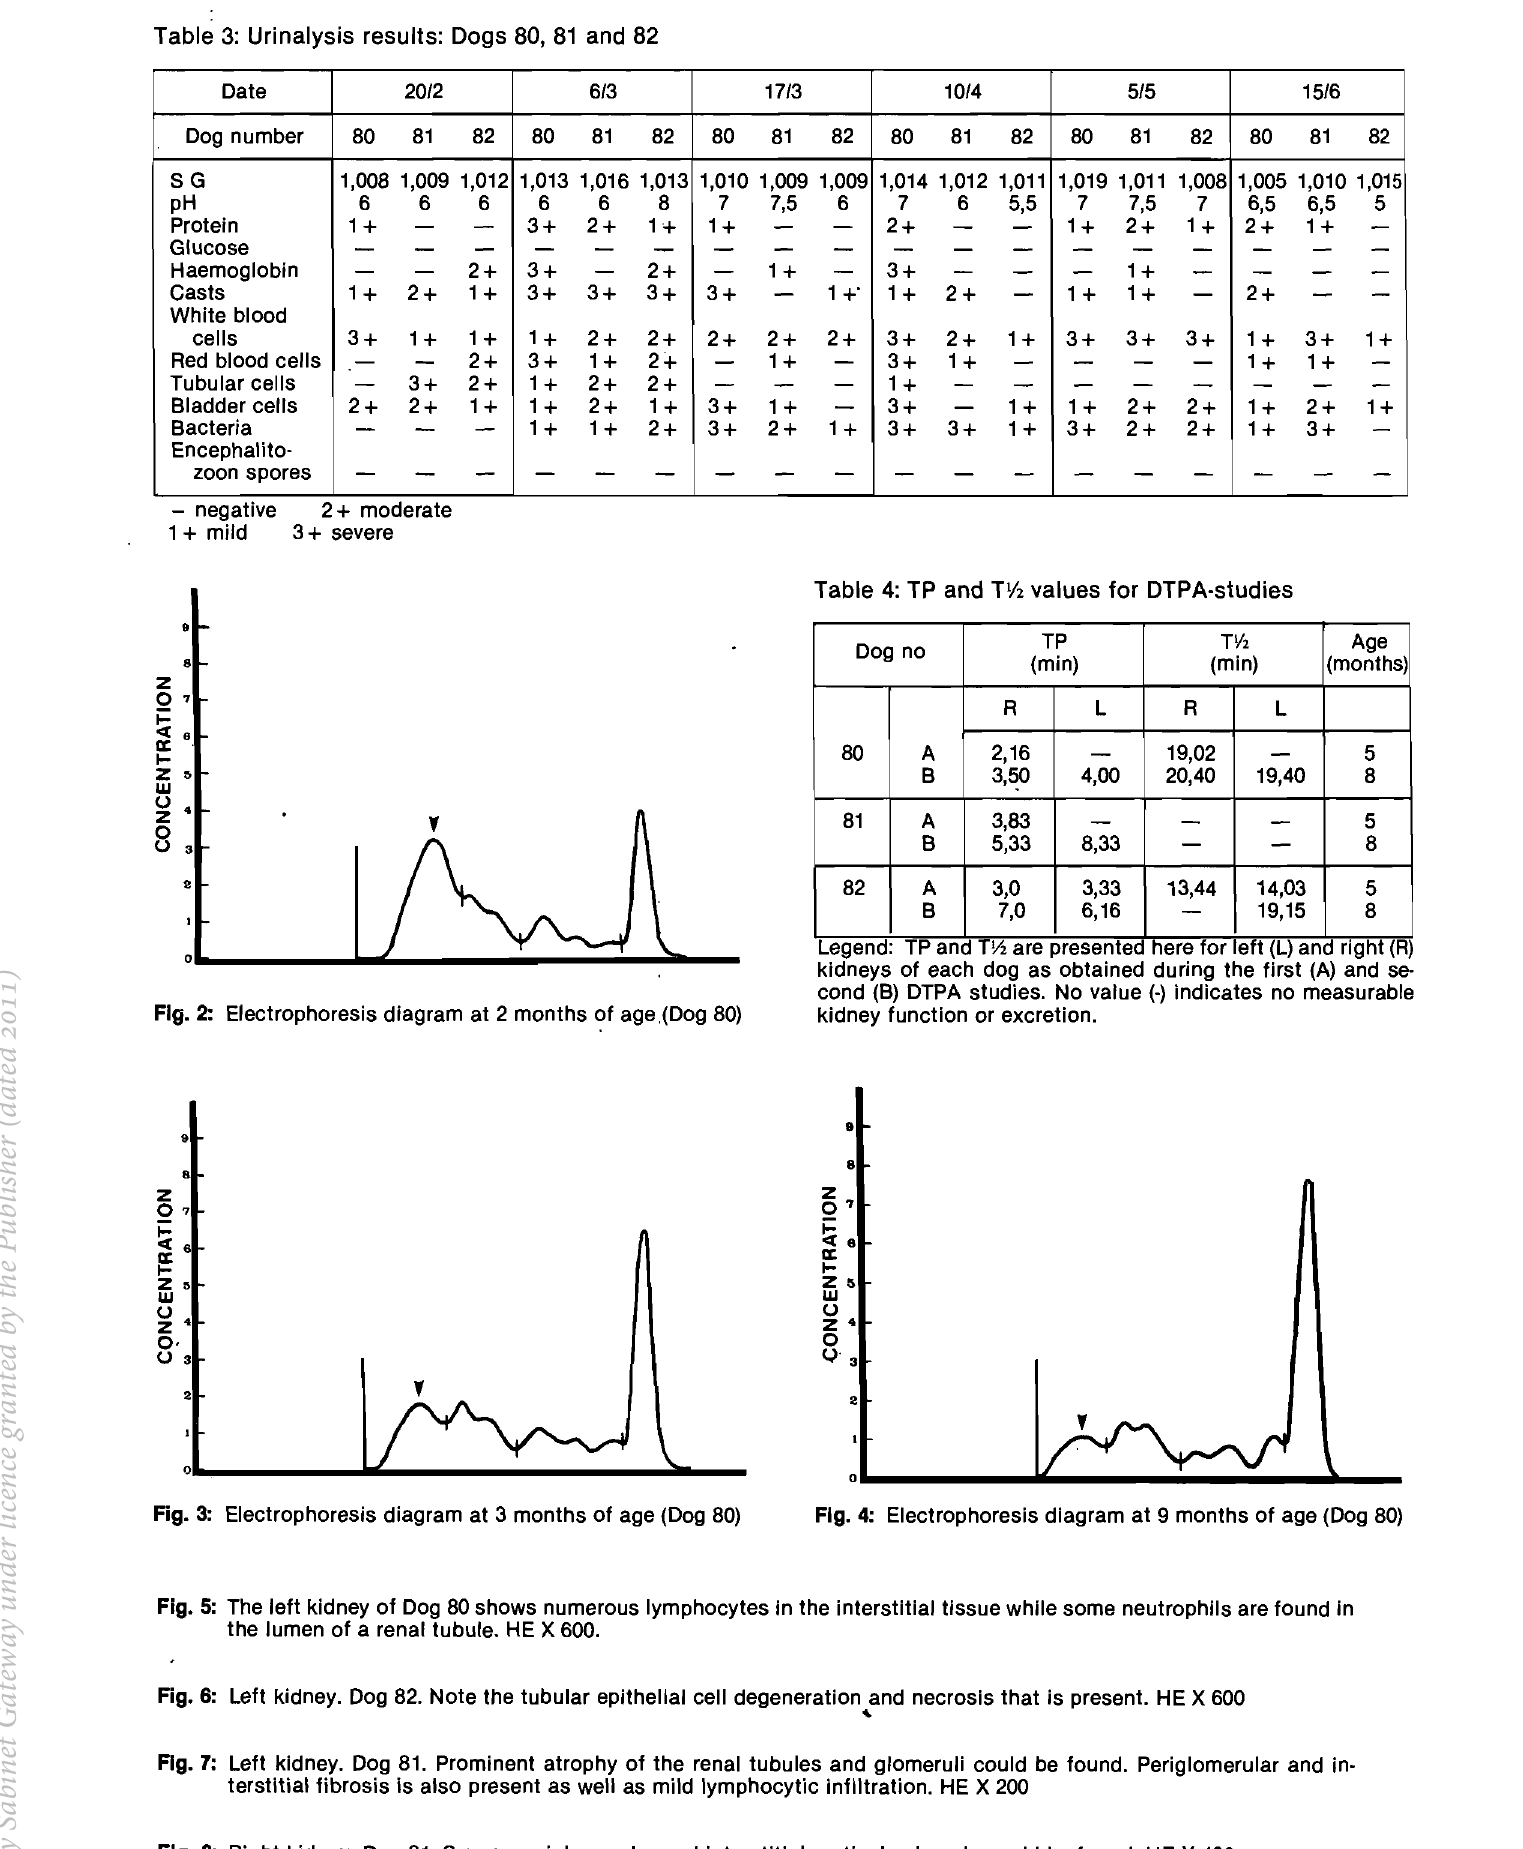
Table 3: Urinalysis results: Dogs 80, 81 and 82